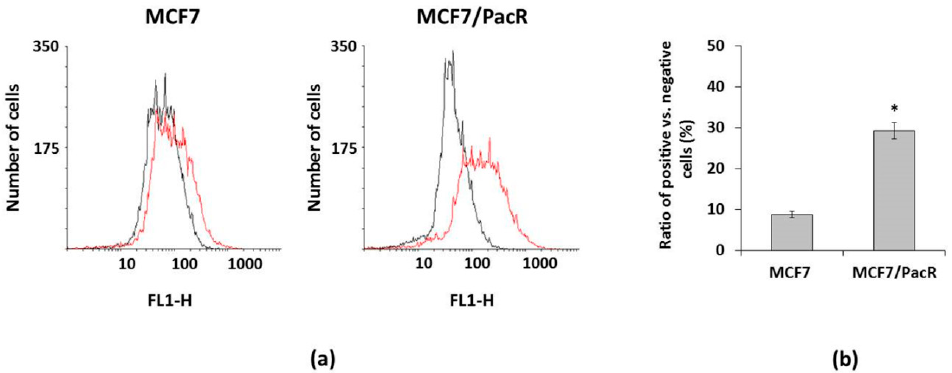
Figure 6. Expression of CPS1 (carbamoyl-phosphate synthetase 1) in paclitaxel-sensitive MCF7 cells and paclitaxel-resistant MCF7 / PacR cells. The expression was assessed employing FACS (see Section 4). The data shown were obtained in one representative experiment from three independent